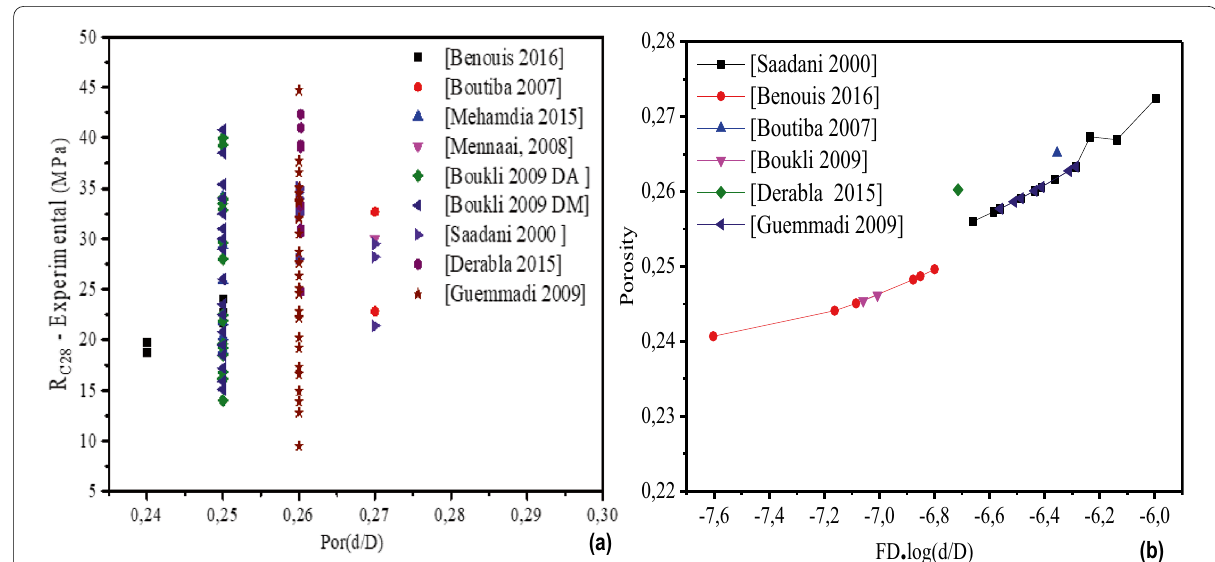
Fig. 9 Relationship between the porosity Por( d / D ) of the basic granular mixture and R C28 of concrete. a Strength as a function of the porosity Por ( D / d g ) , b porosity Por ( d / D ) according to the model FD.log ( d / D )